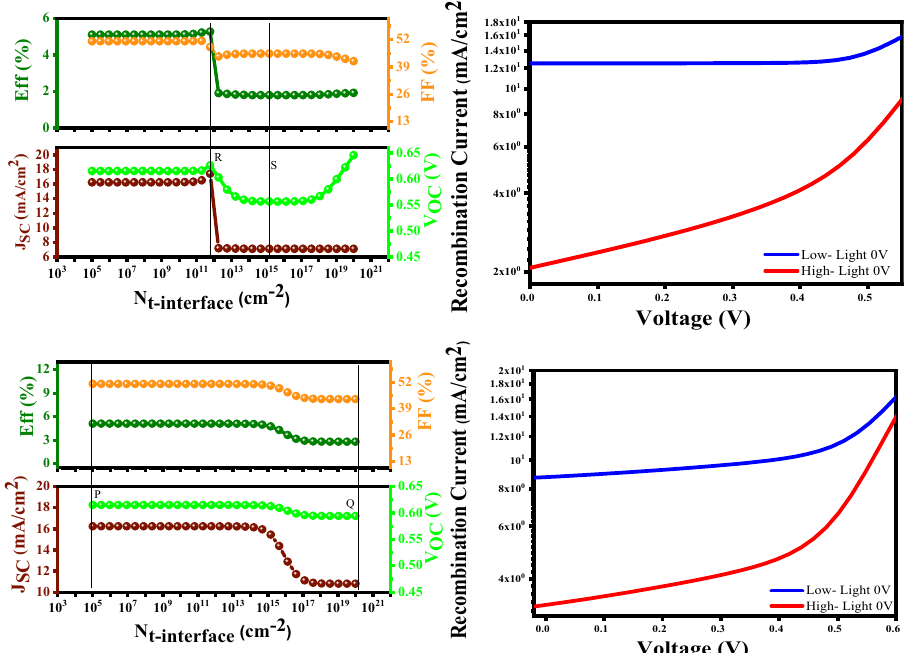
Figure 13. Variation of the solar cell parameters of the CBT (S, Se) solar cells with different N t-interface (cm −2 ) of the In 2 S 3